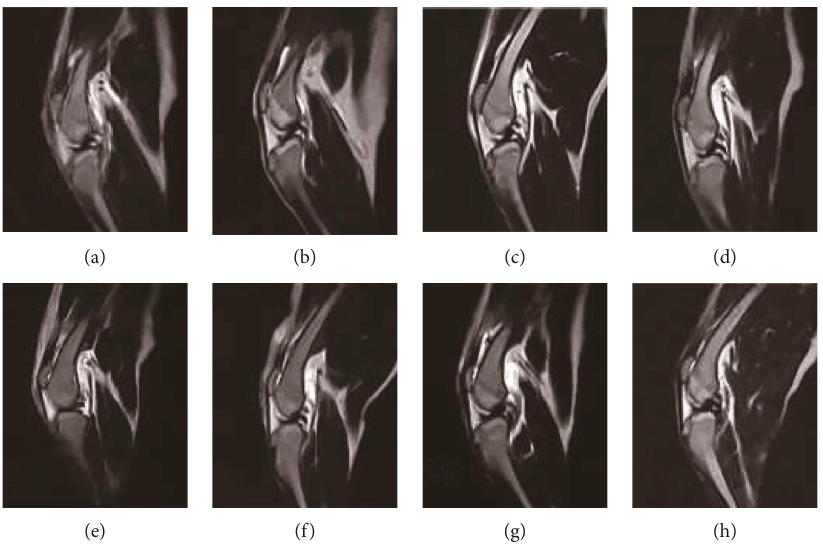
Figure 3: Magnetic resonance imaging of canine arthritis after the treatment: (a) 3 days after cell therapy, (b) 7 days after cell therapy, (c) 14 days after cell therapy, (d) 28 days after cell therapy, (e) 3 days after treatment in the untreated control group, (f) 7 days after treatment in the untreated control group, (g) 14 days after treatment in the untreated control group, and (h) 28 days after treatment in the untreated control